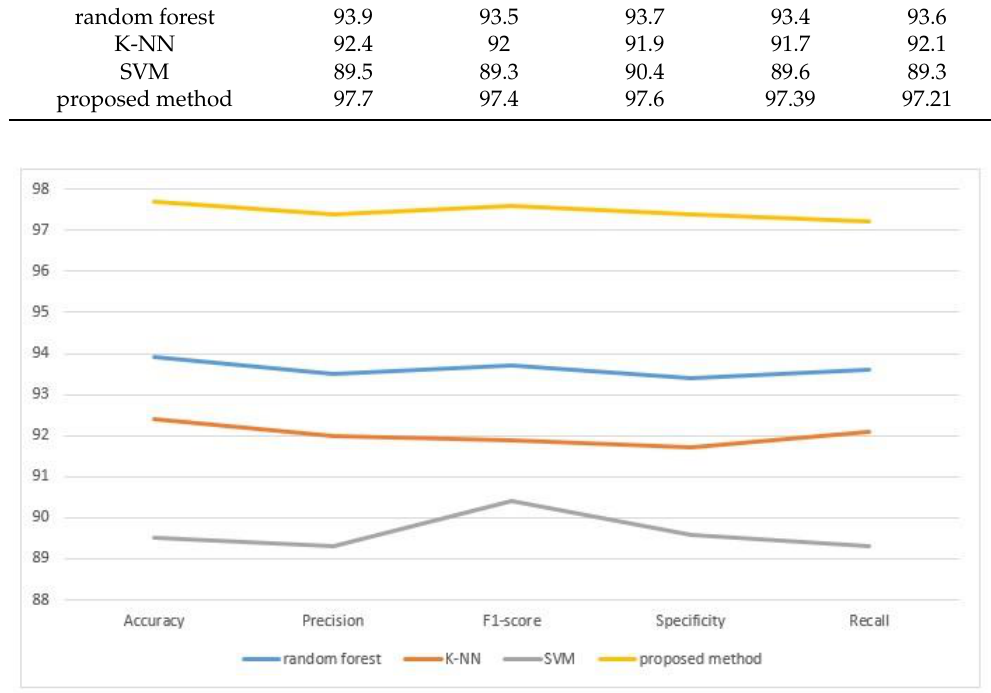
Figure 5. The performance metrics for shallow machine learning compared with our proposed method.